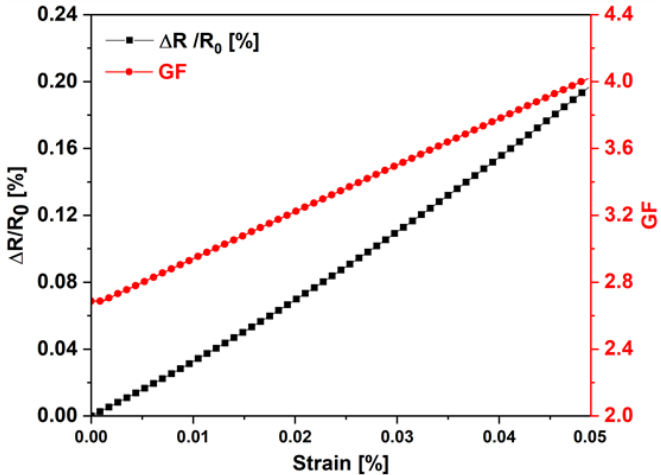
Figure 10. Trends of percentage change of resistance and variation of the gauge factor in the piezoresistive sensor subjected to the three-point bending test, as a function of deformation.